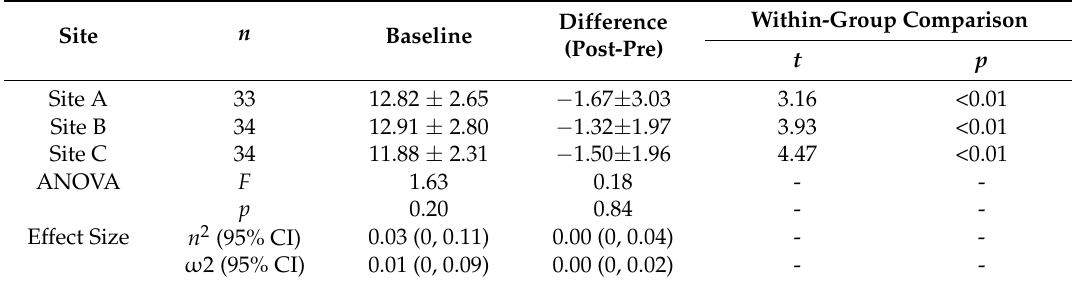
Table 4. Pre- and post-visit comparison of levels of demands across the three sites ( n = 101). Site